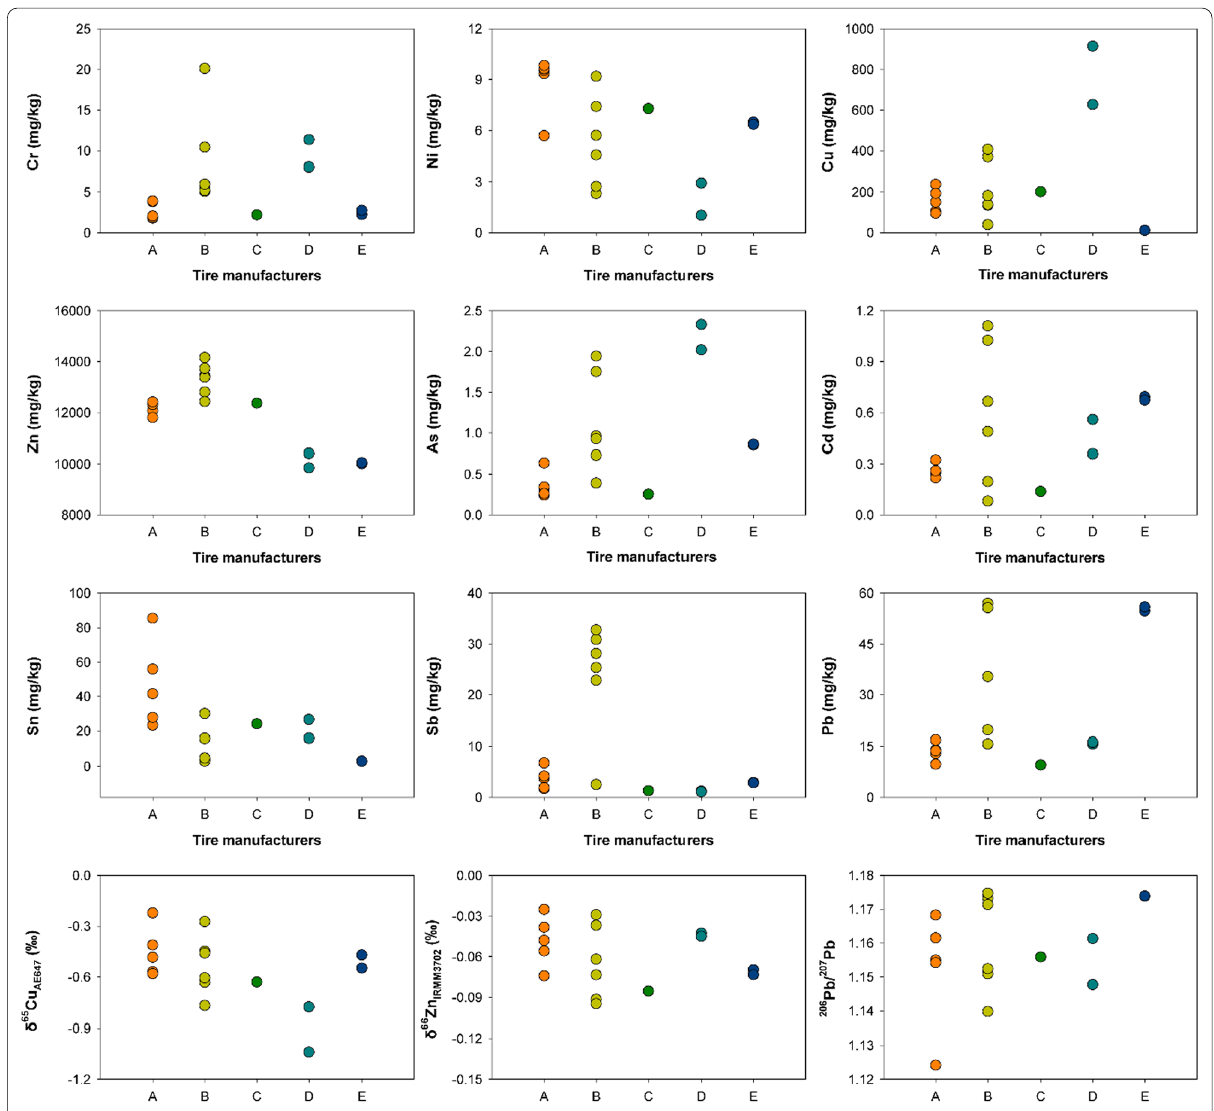
Fig. 1 Comparisons of toxic metal concentrations (mg/kg) and isotopic compositions of Cu, Zn, and Pb among the different tire samples in this